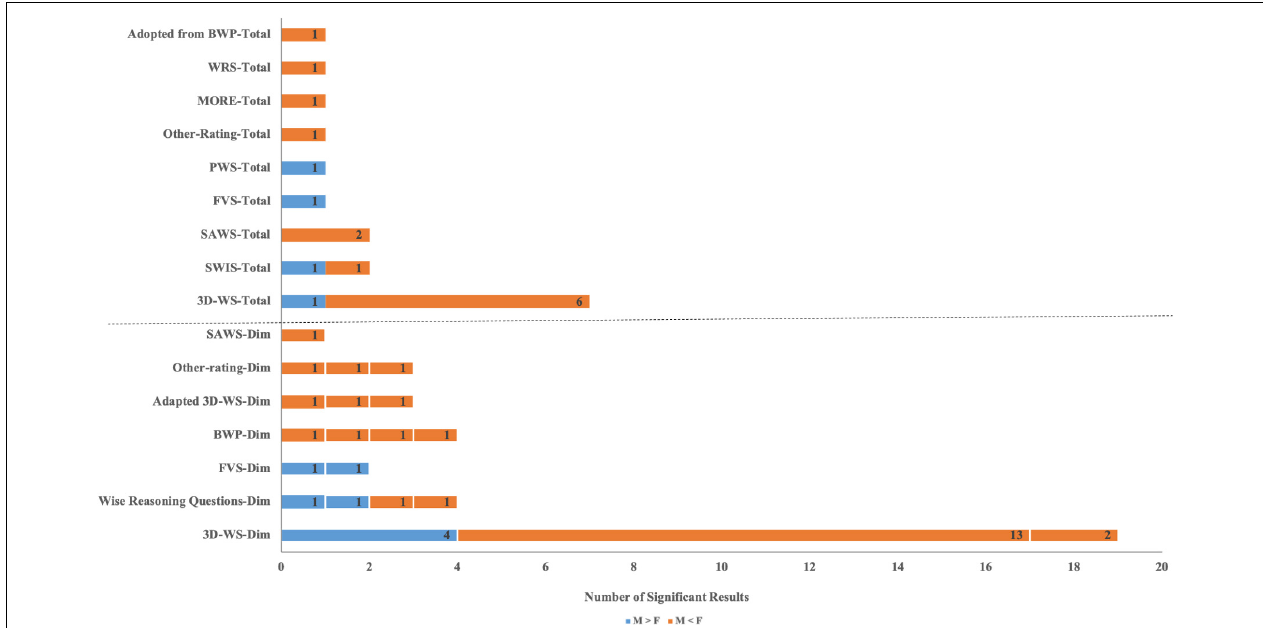
FIGURE 2 | Summary of significant gender effects on levels of wisdom. Significant gender effects on levels of overall wisdom were shown above the horizontal dotted line, and significant gender effects on levels of wisdom dimensions were shown below the horizontal dotted line, with white vertical lines used to separate the significant results for the different dimensions of each scale. The names of dimensions with significant gender effects were as follows, in order from top to bottom and left to right: (1) SAWS: reminiscence; (2) Other rating: flexibility, perspective taking, recognition of limits of knowledge; (3) Adapted 3D-WS: nondualistic thinking, non-resentment, empathy; (4) BWP: use of procedural knowledge, lifespan perspective, relativism of values, management of uncertainty; (5) FVS: warmth*, intelligence*; (6) Wise reasoning questions: perspectives*, limits of knowledge*, emotional reactivity, compromise; (7) 3D-WS-Dim: reflective*, affective (compassionate),